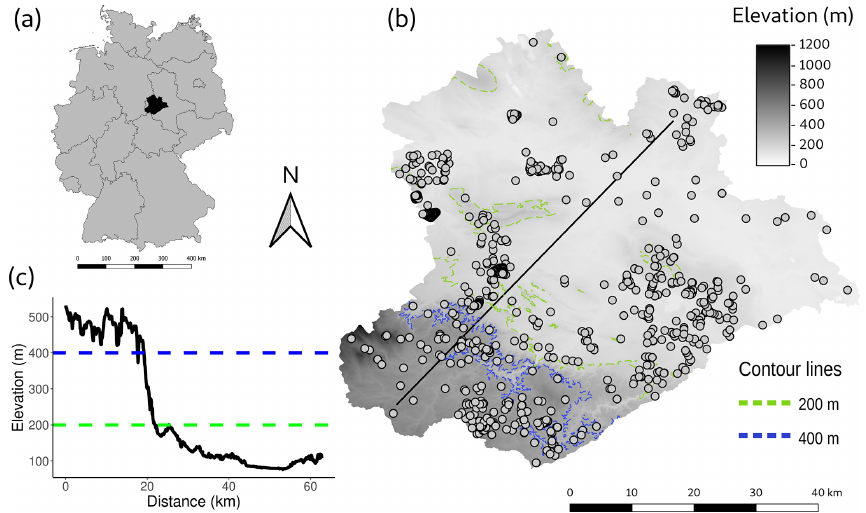
Figure 1. Study area (a) location in Germany, (b) location of the survey sites, (c) and cross-sectional elevation profile (black line on the